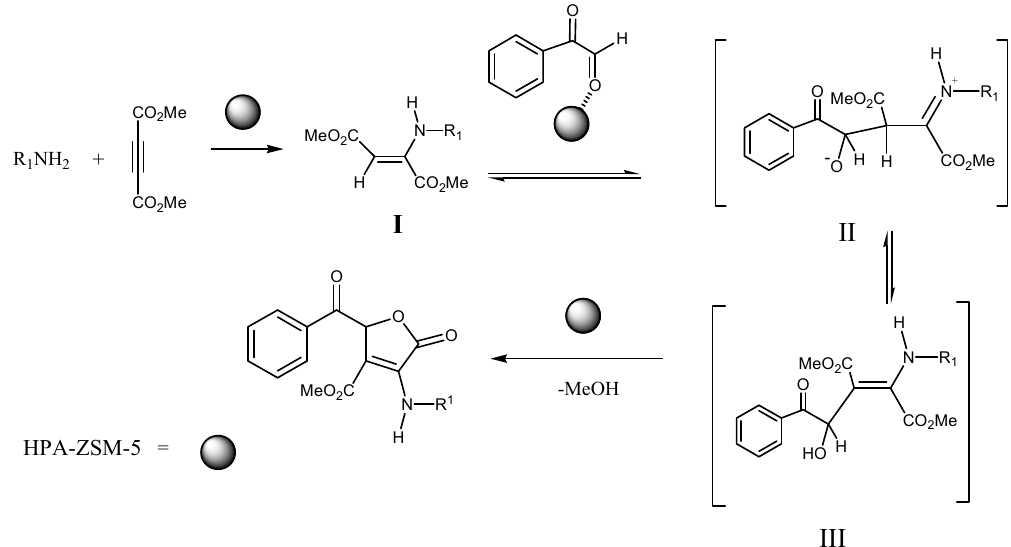
Scheme 2. Schematic mechanism for the catalytic activity of HPA-ZSM-5 for the synthesis of